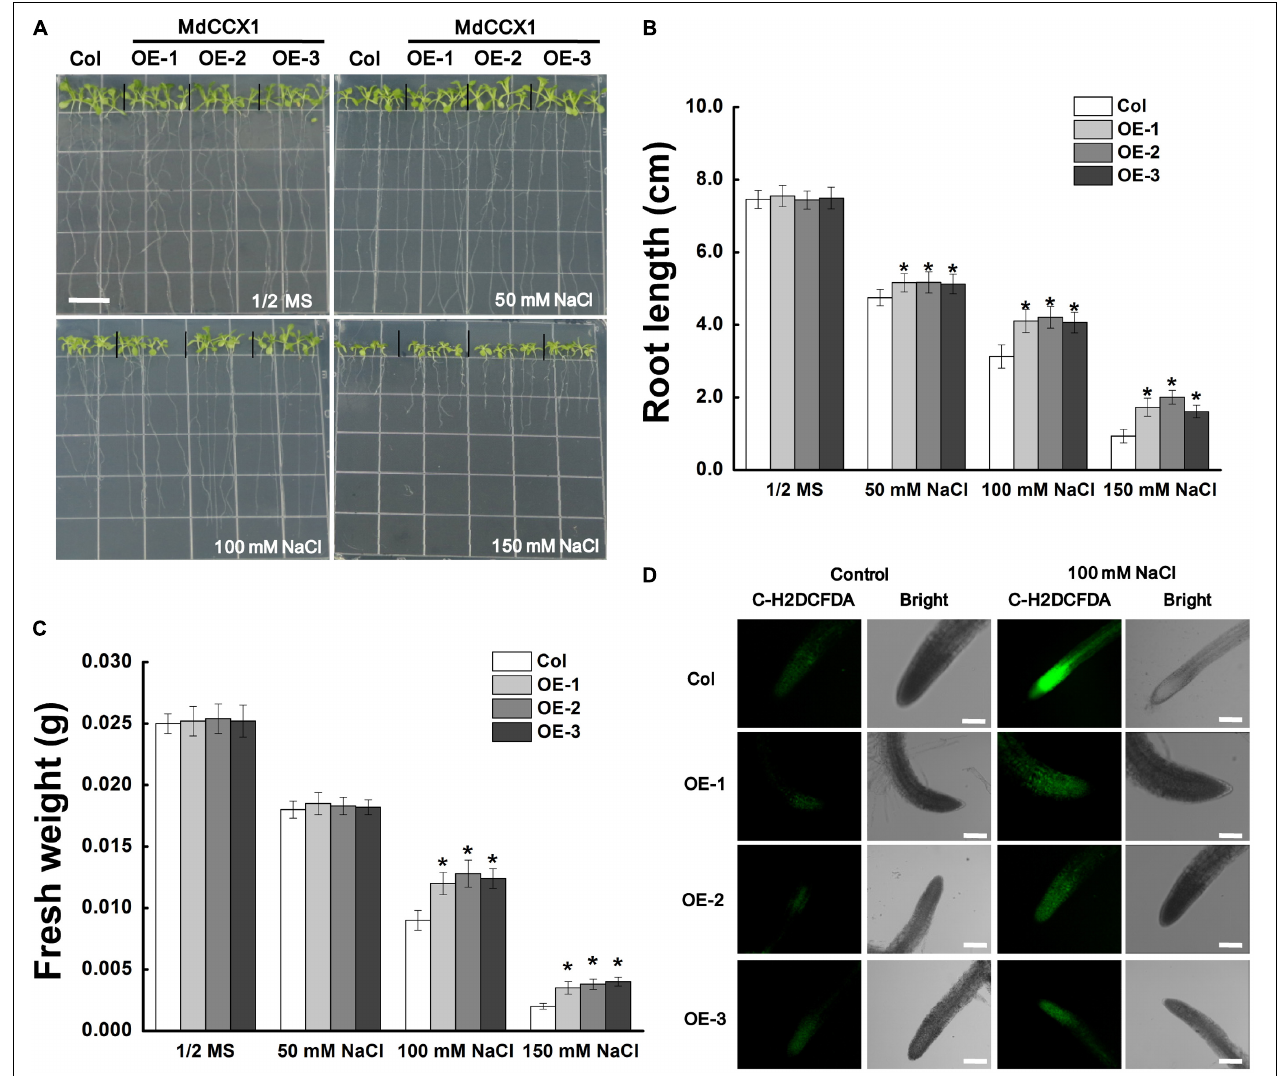
FIGURE 5 | Phenotypic comparison of “Col” and MdCCX1 -overexpressing transgenic Arabidopsis seedlings under NaCl stress. (A) Representative images of five-day-old “Col” and transgenic seedlings had been cultivated for 6 d on 1/2 MS medium supplemented with 0, 50, 100, and 150 mM NaCl. Bars = 1 cm. Root length (B) and fresh weight (C) of whole seedling in (A) . Error bars represent SD based on 3 independent replicates. (D) Accumulation of ROS in root tips treated with 100 mM NaCl in (A) . Roots were labeled with the ROS-sensitive fluorescent probe C-H2DCFDH. The bright and fluorescence fields are represented. Scale bars, 100 µ m. For (B,C) , bars labeled with * in each panel indicates values that are significantly different relative to “Col” at p < 0.05, using Student’s t-test